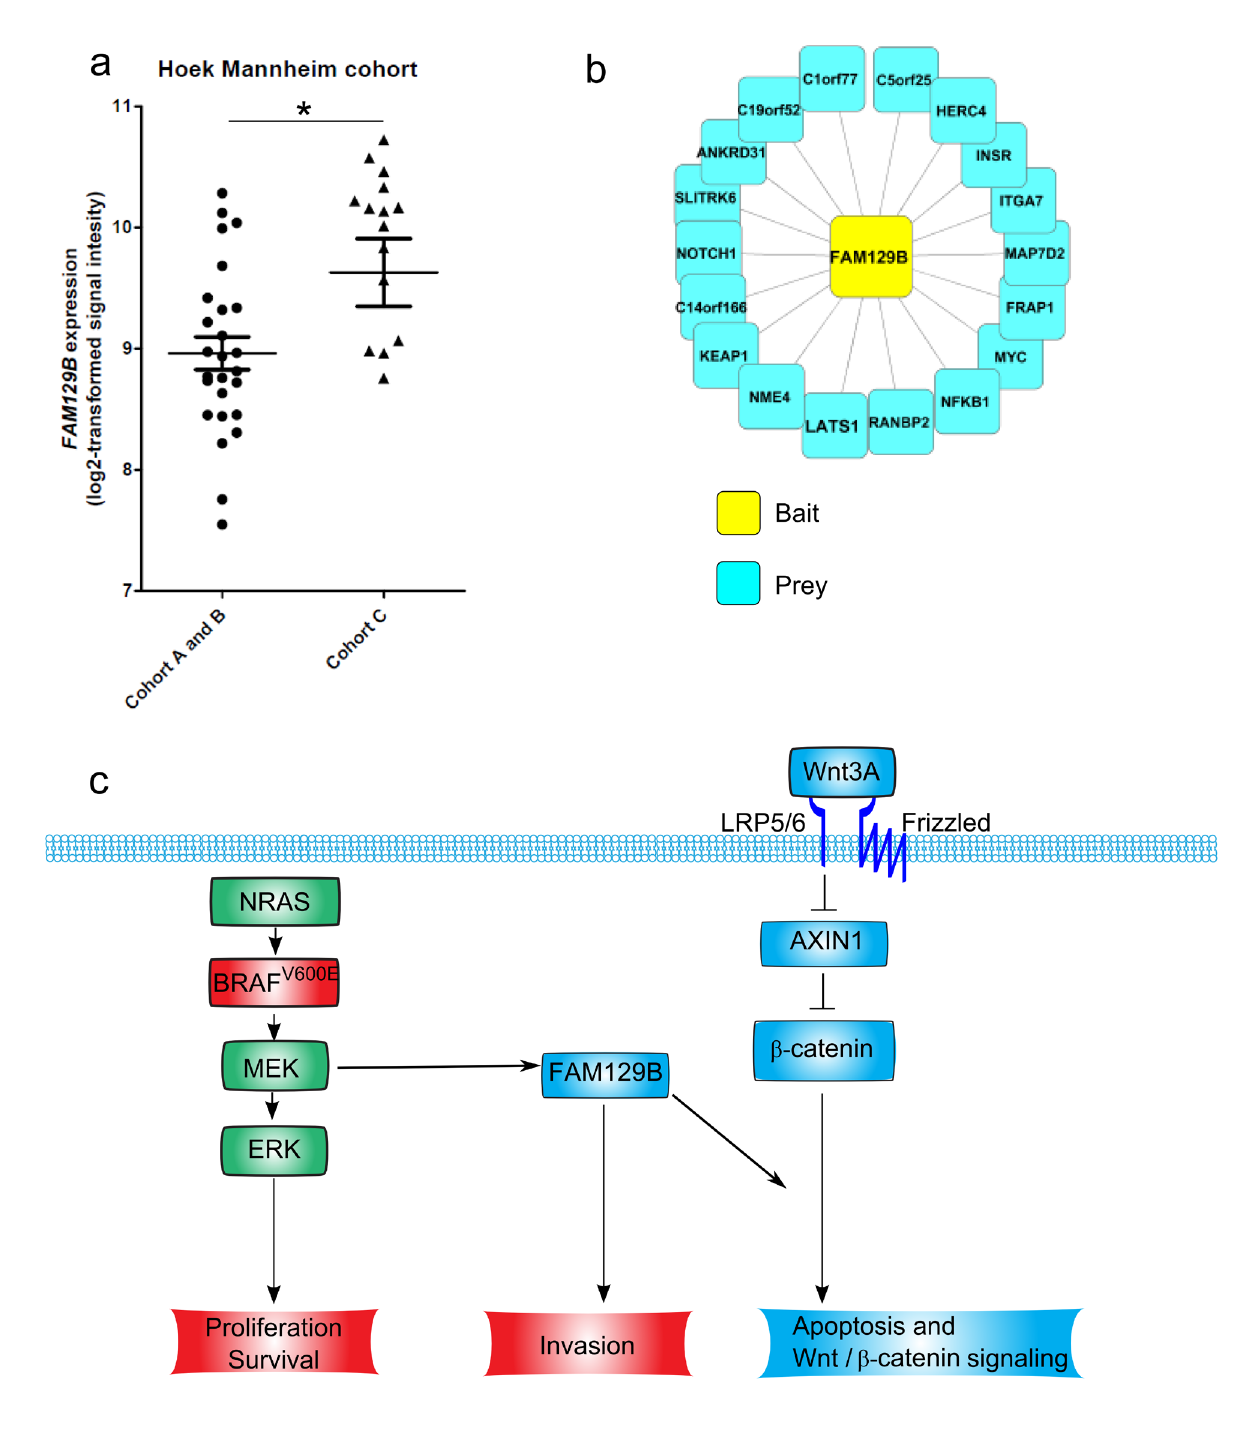
Figure 5. ( a ) FAM129B expression associates with an invasive cohort of patient melanomas. FAM129B gene expression was compared between three previously identified melanoma cohorts. We compared FAM129B expression in cohorts A and B with cohort C. Log(2) transformed expression for FAM129B was significantly higher in cohort C than in cohorts A and B (8.962 ± 0.1355 vs 9.629 ± 0.2795, p= 0.0214) ( b ) FLAG-purification of FLAG-GFP-FAM129B unveils multiple FAM129B interactors. Nodes depict FAM129B interacting proteins identified by affinity purification/mass spectrometry. Bait protein Flag-GFP-FAM129B is depicted in yellow. Prey proteins are depicted in blue. ( c ) Model of FAM129B regulation by ERK/MAPK signaling in melanoma and regulation of Wnt/ β -catenin signaling. FAM129B is a substrate downstream of active MEK (green) that is required for melanoma invasion 13 . We identified FAM129B as a positive regulator of Wnt/ β -catenin signaling